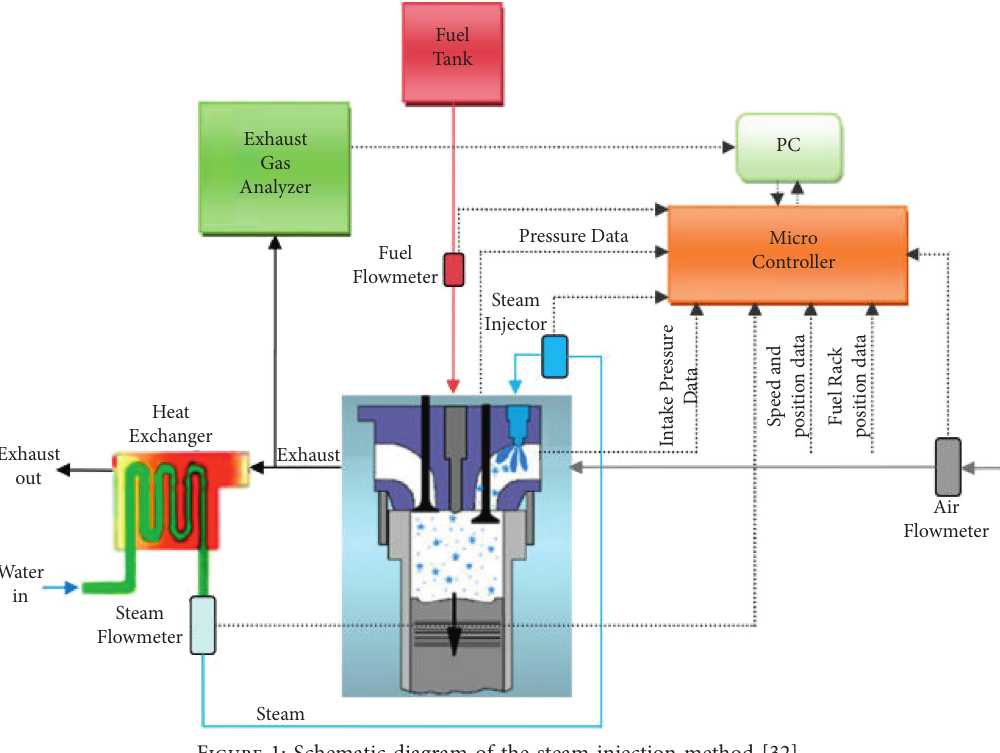
Figure 1: Schematic diagram of the steam injection method